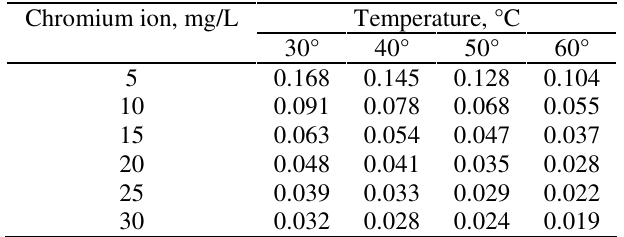
Table 4. Dimensionless separation factor (R